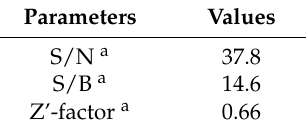
Figure 1. Establishment of a high-throughput screening (HTS) platform for anti-fatty liver drug screening. ( A ) Huh7 cells were used as a cell model for lipid accumulation by treating with 125 μM oleic acid (OA) for 24 h. LD numbers were determined as described in Section 4. Nuclei and lipid droplets (LDs) were stained with Hoechst 33342 (blue) and BODIPY ® 493/503 (green), respectively. A granularity analyzing module was used to identify nuclei and LDs automatically. Yellow and blue masks the identified nuclei and LDs, respectively. Bar: 50 μm ; ( B ) Variation test for platform evaluation. LDs/cell were determined in three experimental groups: OA (squares) and bovine serum albumin (BSA) (circles). In each group, 32 wells were tested. The average of LD counts in the OA group was used as a standard for 100%. Each dot represents a mean relative LD count from nine fields for one well. Solid lines represent the mean relative LD count and dashed lines represent ± 3 standard deviation (SD) for each group; ( C ) The platform was tested using Triacsin C (TC) as an inhibitor of LD accumulation. LD assay was performed as described in ( A ) in the absence or presence of TC at indicated concentration. Table 1. Statistical parameters of screening platform.